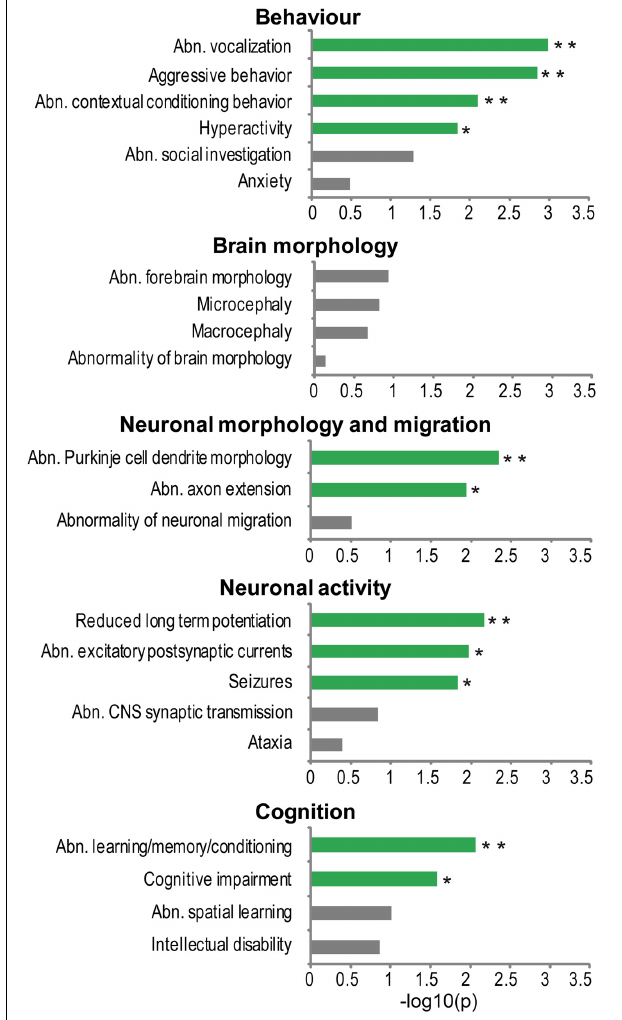
FIGURE 3 | Enrichment of tissues with highest expression in NHGRI-cross-disorder genes. − log 10 ( p -value) of enrichment of all tissues with highest expression level of NHGRI-cross-disorder genes. The most prominent tissue is brain with a significant enrichment of p = 2 . 42 x 10 − 5